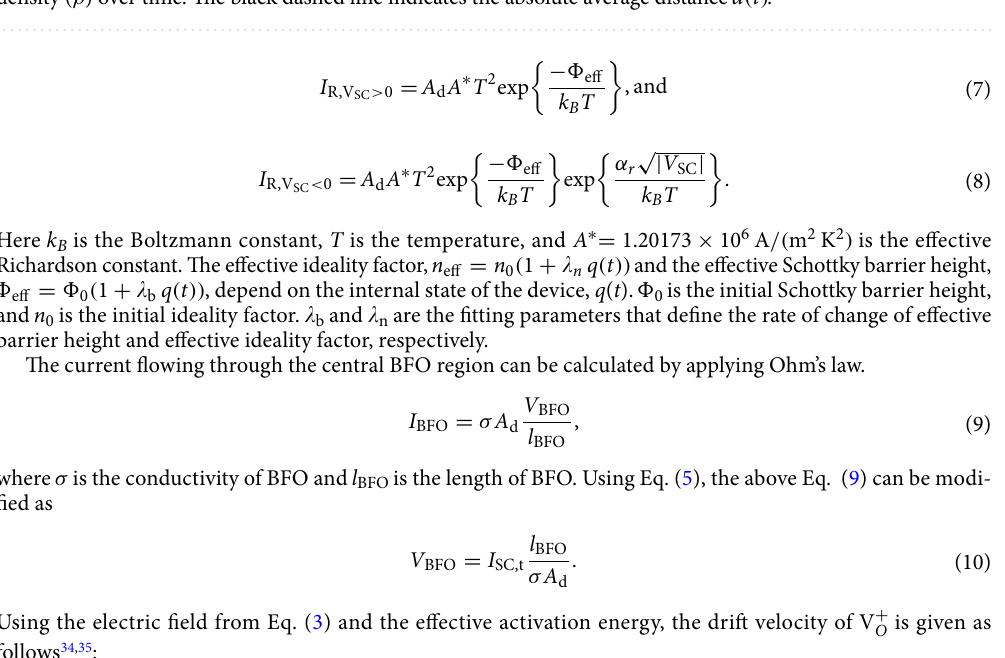
Figure 3. The resistive switching process in BFO memristor. ( a ) Calculated and experimentally obtained I – V characteristics of the BFO memristor, ( b ) the change in activation energy with time across the BFO device during the set and reset process, and ( c ) the ion transport in BFO memristor shown as a change in charge density ( ρ ) over time. The black dashed line indicates the absolute average distance